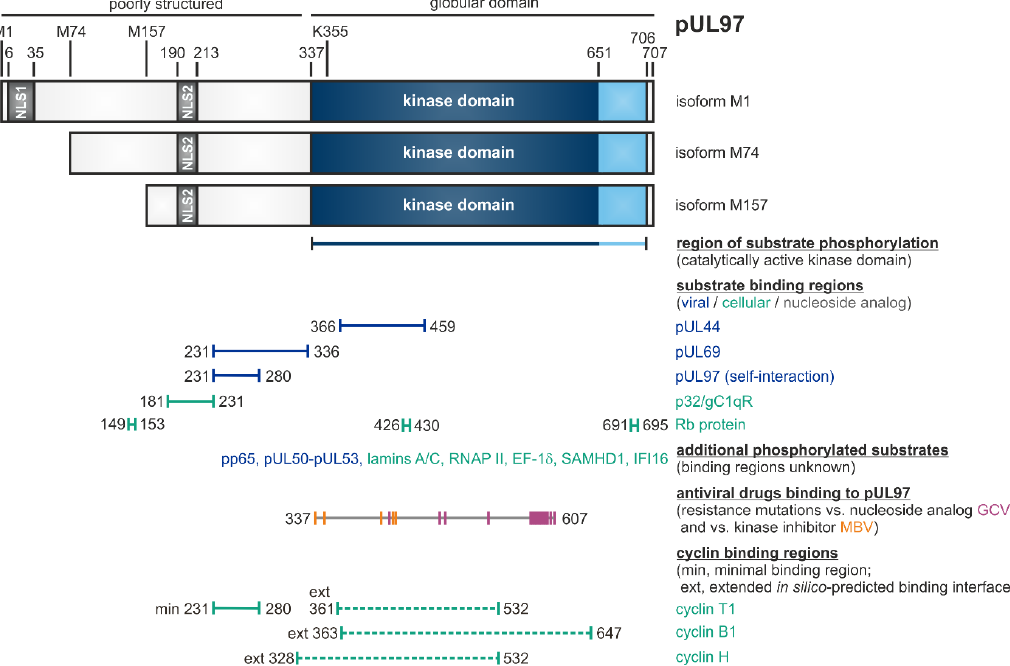
Figure 1. Schematic illustration of the modular structure and the so far identified binding regions within pUL97 [56]. The kinase domain is located between amino acids 337 and 706, as based on biochemical validation(or337and651, asbasedonsequencehomologies).